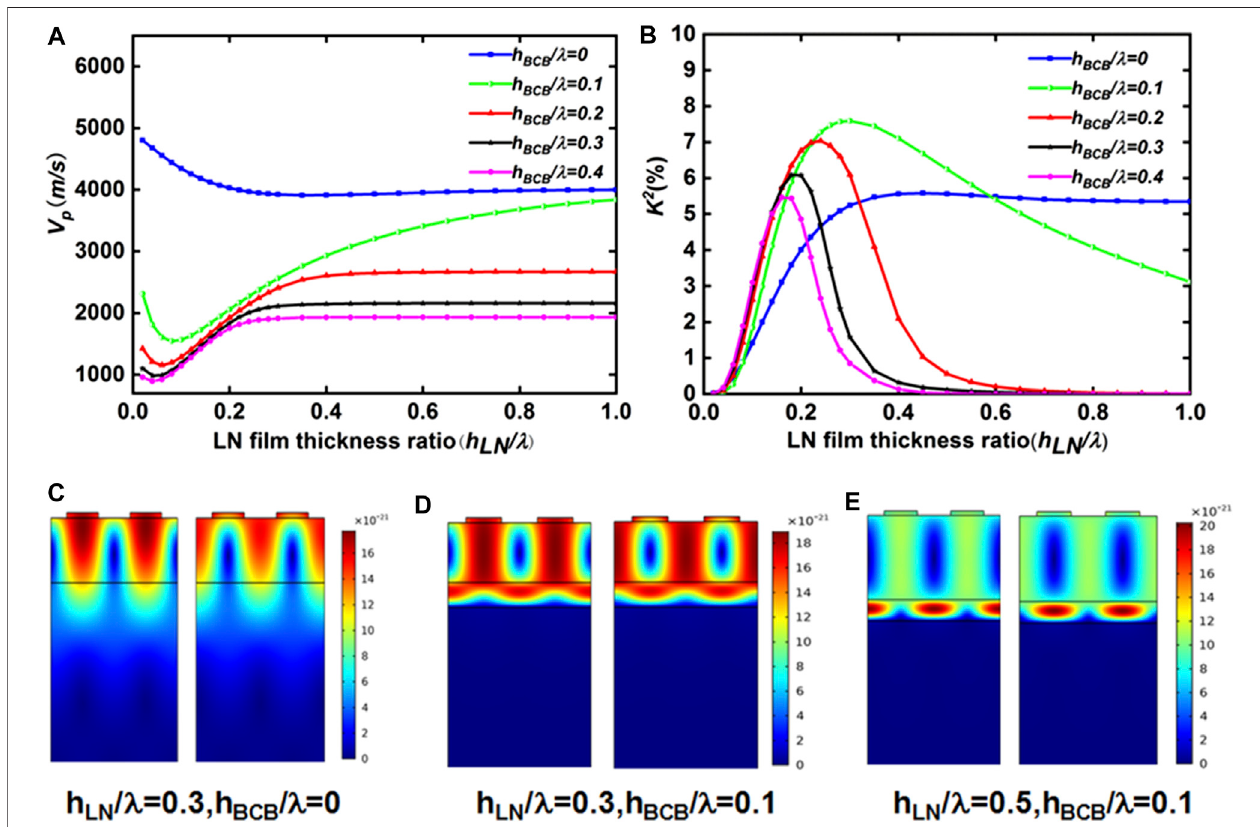
FIGURE 8 | (A) v p dispersion curves and (B) K 2 dispersion curves of the 128 ° Y – X LN POS substrate, (C) vibration mode of POS substrates with h LN / λ (cid:2) 0.3 and h BCB / λ (cid:2) 0, (D) vibration mode of POS substrates with h LN / λ (cid:2) 0.3 and h BCB / λ (cid:2) 0.1, (E) vibration mode of POS substrates with h LN / λ (cid:2) 0.5 and h BCB / λ (cid:2)